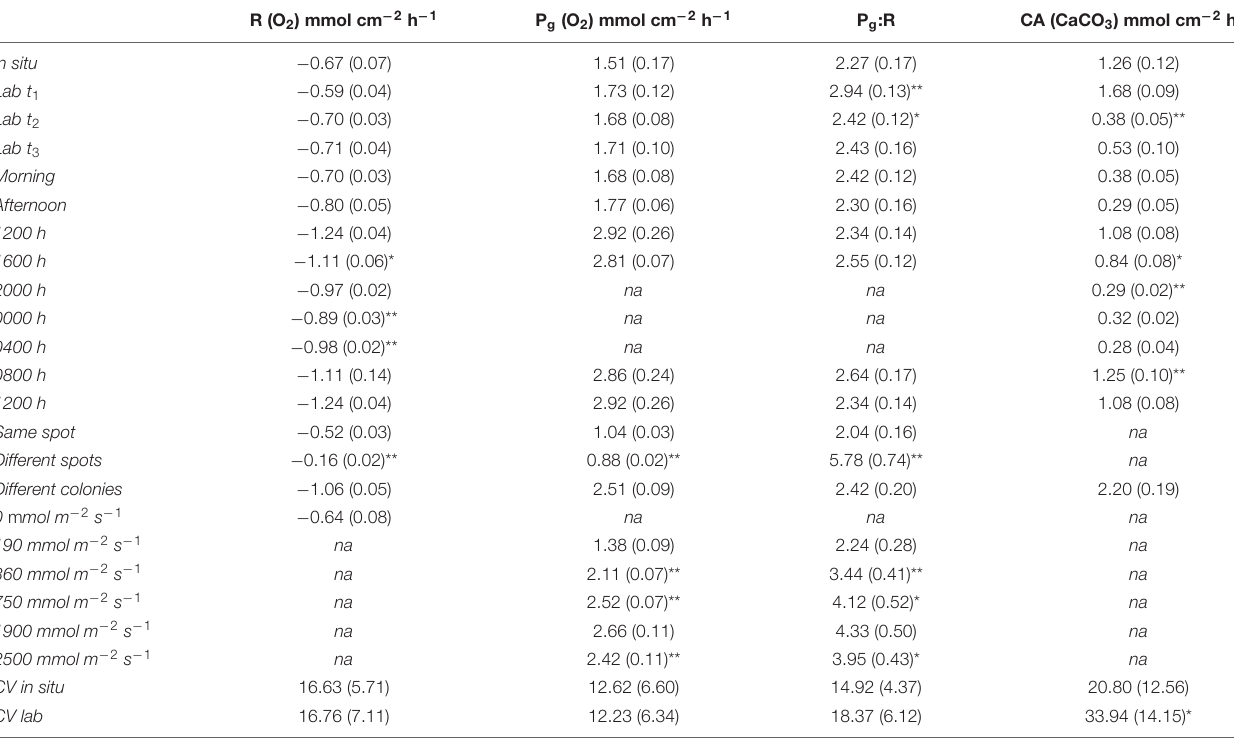
TABLE 2 | Metabolic rates measured in different conditions in this